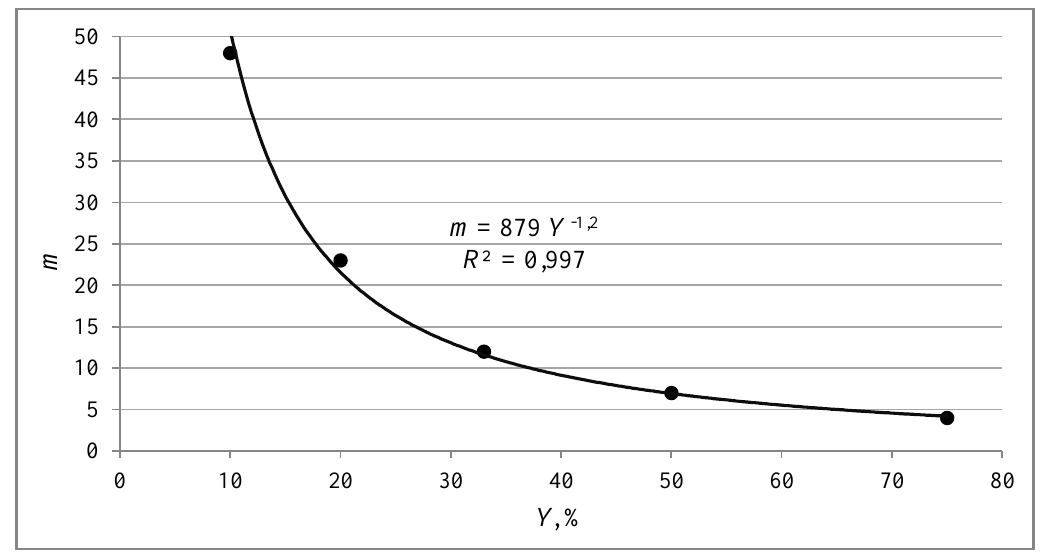
Figure 2. Dependence of the average number of negotiations m from level of unilateral concessions Y by members of small coalition (index of coalition influence I =